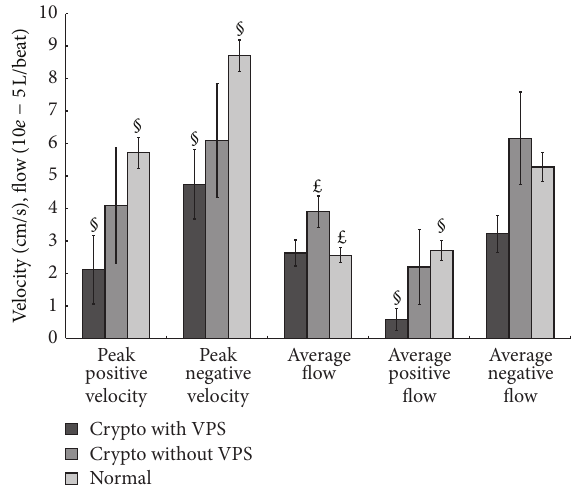
Figure 2: Cine MRI parameters of patients with and without shunts as compared with healthy controls. § Significant difference between the patients with shunts and controls. m Significant differ- ence between the patients without shunts and controls ( 𝑃 < 0.05 ).